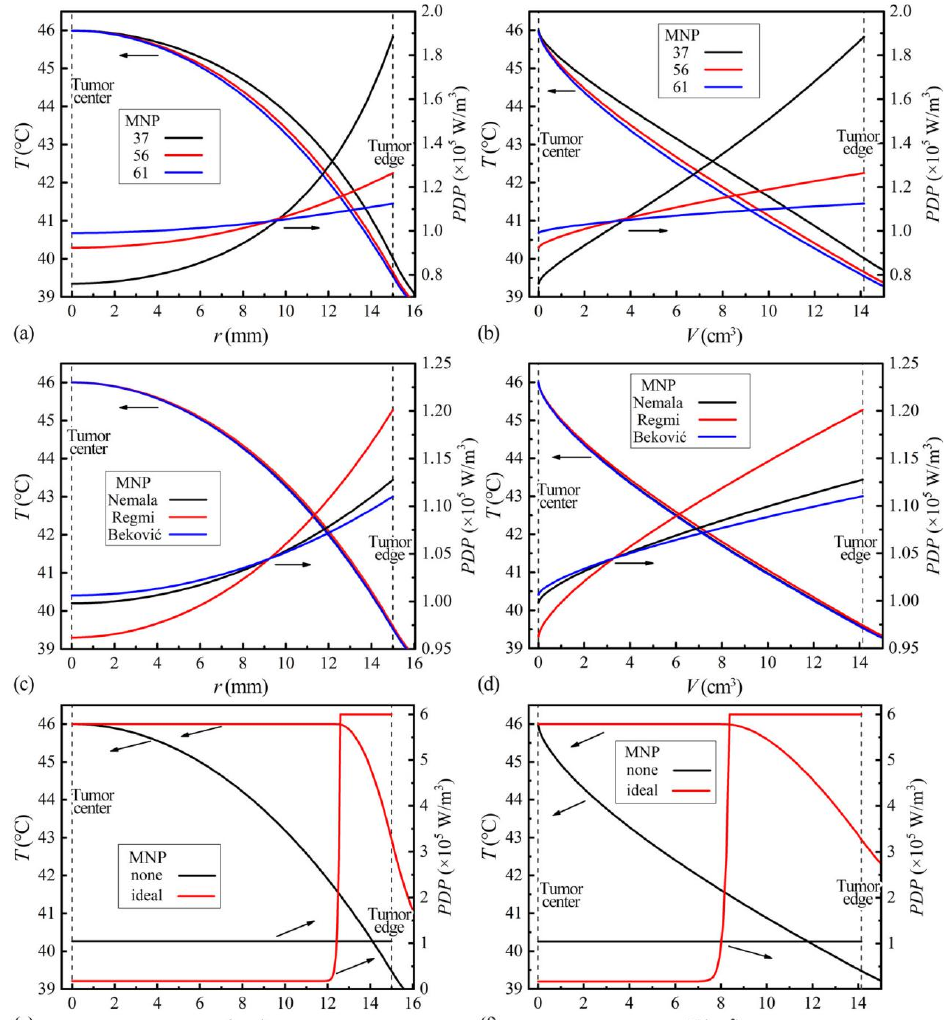
Figure 6. Temperature distributions (left ordinate) and PDP distributions (right ordinate) in the tumor of the ZnCoCrFeO MNPs by radius ( a ), by volume ( b ); of the MNPs from references by radius ( c ), by volume ( d ); and of the MNP ideal and MNP none by radius ( e ), by volume ( f ). In clinical trials, the final temperatures at the tumor center ( T center ) and the tumor edge ( T edge ), as well as the exceeded temperatures in 20% volume ( T 20 ), 50% volume ( T 50 ), 90% volume ( T 90 ) of the tumor are concerned [29]. To quantitatively evaluate the uniformities, the dimensionless parameter U i is defined, shown in Equations (12) and (13).